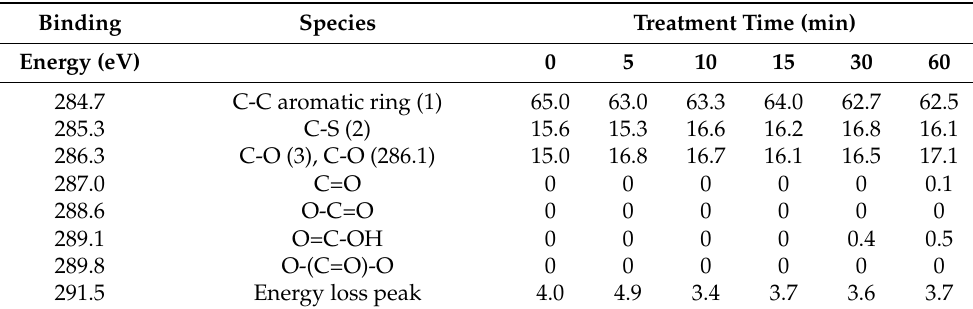
Table 1. Assignments [15] and % areas for the C 1s peaks in Figure 4 as determined by curve-fitting. Carbons (1), (2), and (3) are illustrated in Figure 1.